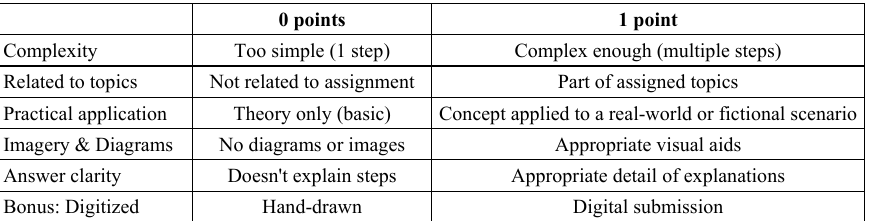
Table 1. Rubric for grading sample